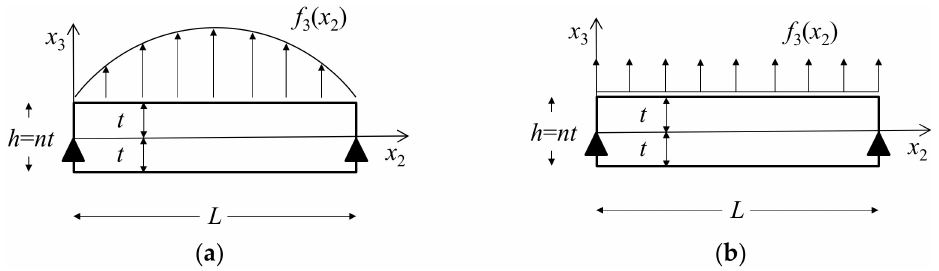
Figure 2. Simply supported beams subjected to: ( a ) sinusoidal and ( b ) uniform transverse